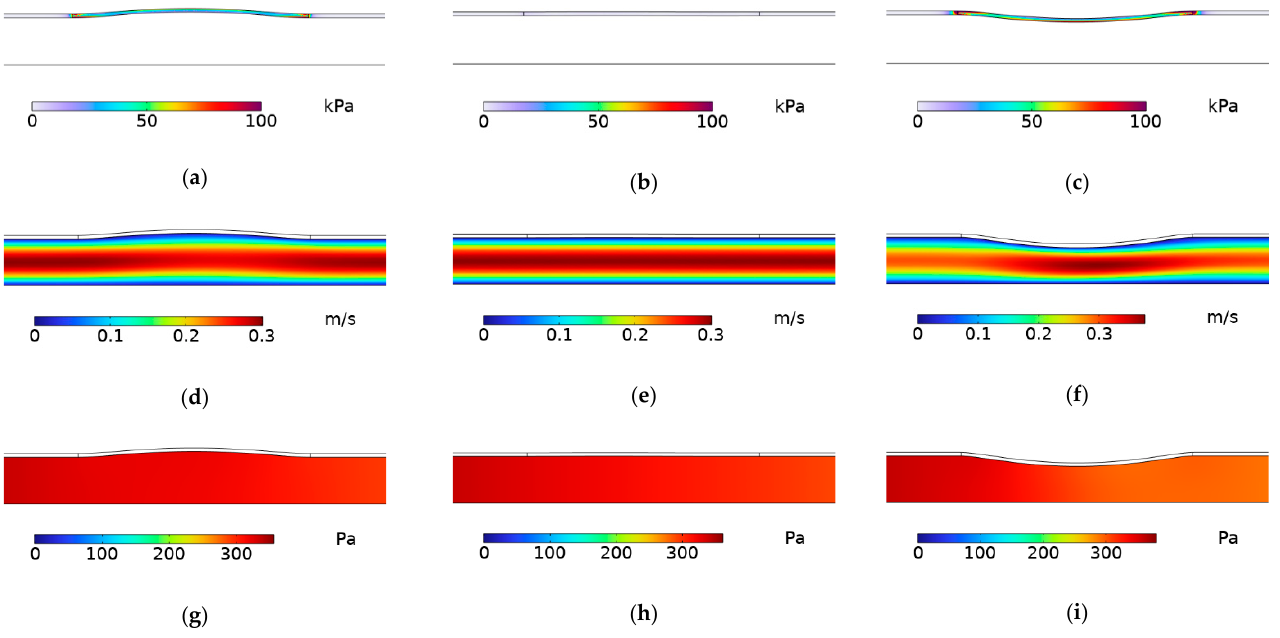
Figure 4. Simulation results of vascular wall stress, blood flow rate, and intravascular pressure under different pressure conditions of blood vessel. ( a – c ) Simulation results of vascular wall stress changes in 𝑃 > 𝑃 (cid:3032) , 𝑃 = 𝑃 (cid:3032) , 𝑃 < 𝑃 (cid:3032) . ( d – f ) Simulation results of blood flow velocity changes in 𝑃 > 𝑃 (cid:3032) , 𝑃 = 𝑃 (cid:3032) , 𝑃 < 𝑃 (cid:3032) . ( g – i ) Simulation results of intravascular pressure changes in 𝑃 > 𝑃 (cid:3032) , 𝑃 = 𝑃 (cid:3032) , 𝑃 < 𝑃 (cid:3032) .